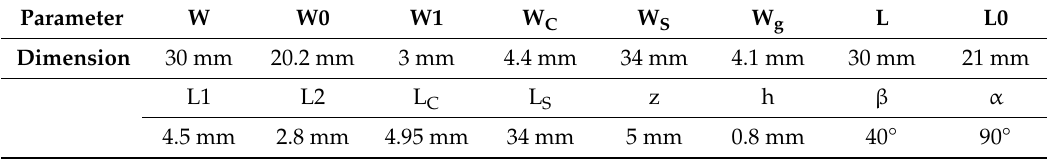
Figure 2. The proposed enlarged antenna center: Top view. Table 1. Dimensions of the proposed antenna.